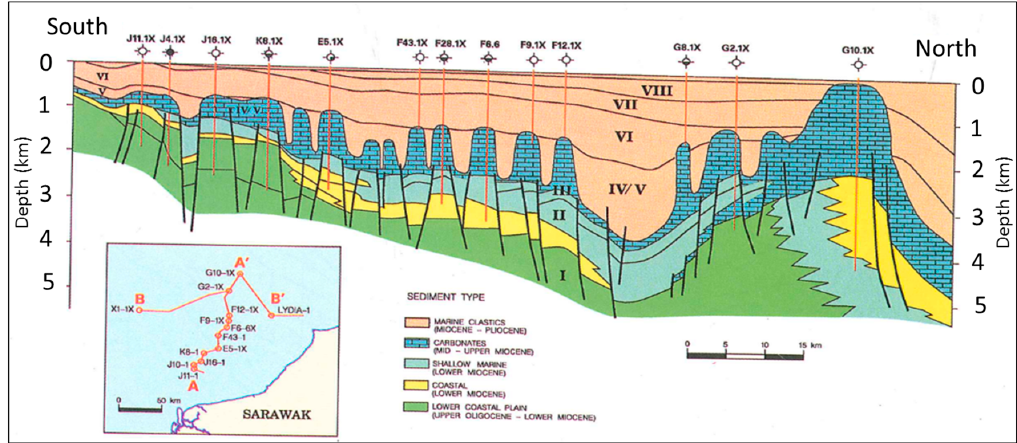
Figure 2. Sarawak basin, an N–S cross-section of the carbonate deposit in central Luconia [10].